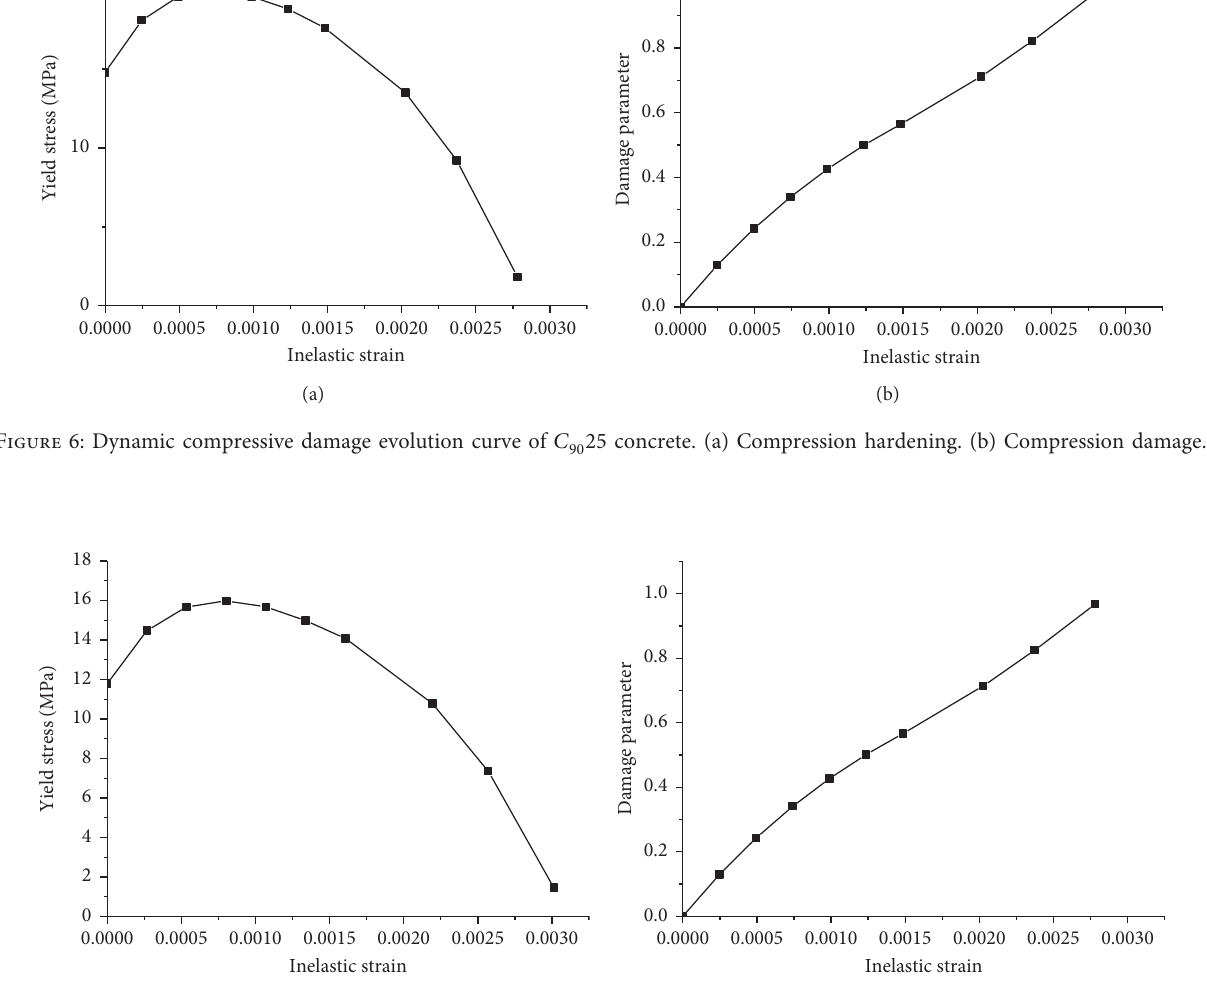
20 concrete. (a) Compression hardening. (b) Compression damage. 90